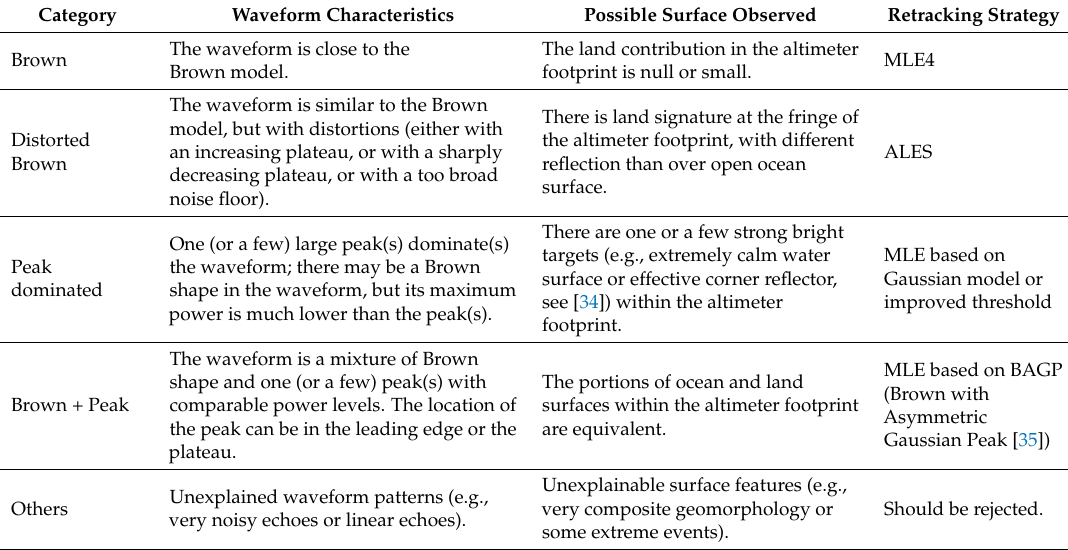
Table 2. Overview of the five categories defined from the 16 PISTACH